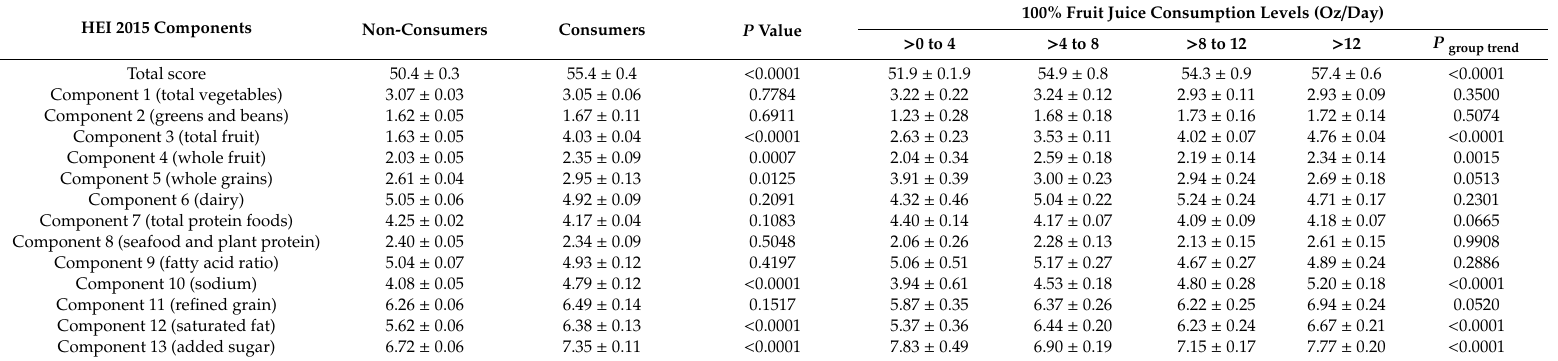
Table 4. Healthy Eating Index (HEI) 2015) and sub-component scores associated with 100% fruit juice consumption in adults (19 + years of age, n = 9152)—NHANES 2013–2016